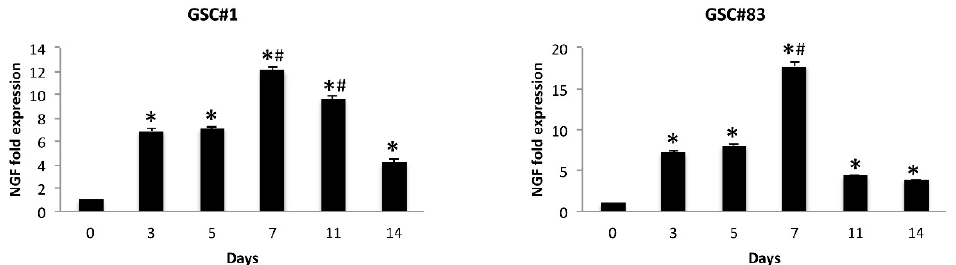
Figure 7. NGF modulation during GSC differentiation. Relative NGF mRNA expression during GSCs differentiation was evaluated by qRT-PCR. NGF mRNA levels were normalized for GAPDH expression and were expressed as relative fold with respect to the corresponding GSC lines used as calibrator. * p < 0.001 vs. undifferentiated NSCs; # p < 0.01 vs. 3, 5, 11, 14 days of differentiation.